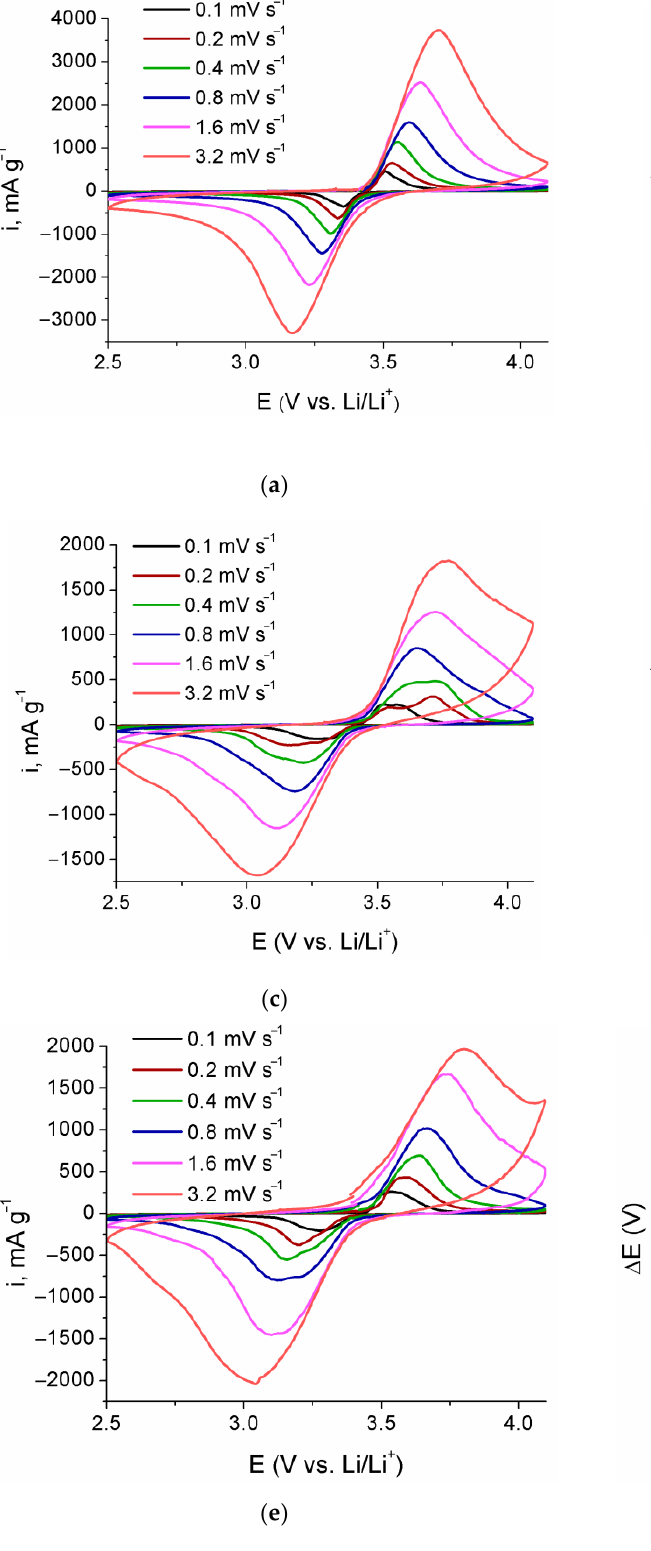
Figure 8. Cyclic voltammetry curves for the LFP/C PANI -II ( a ), LFP/С/5N -CNT ( b ), LFP/С/10N -CNT ( c ), LFP/С/5N -CNP ( d ), and LFP/С/10N -CNP ( e ); the peak potential differences for these composites ( f ).